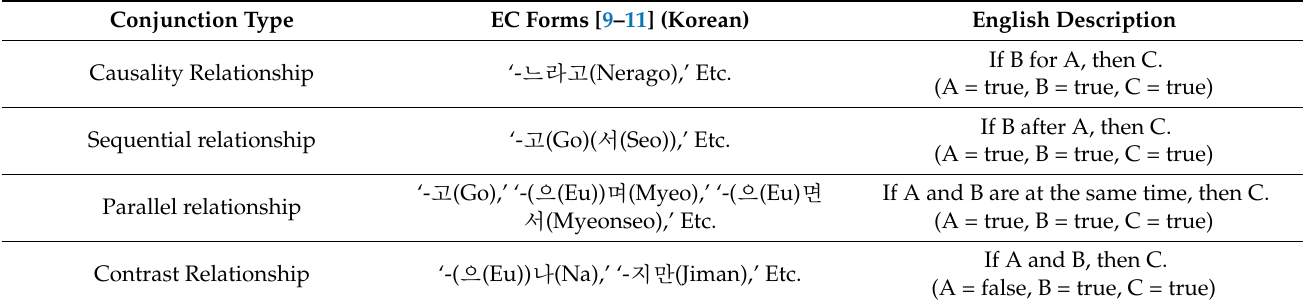
Table 4. Parts of Combination Types between Conjunctions.